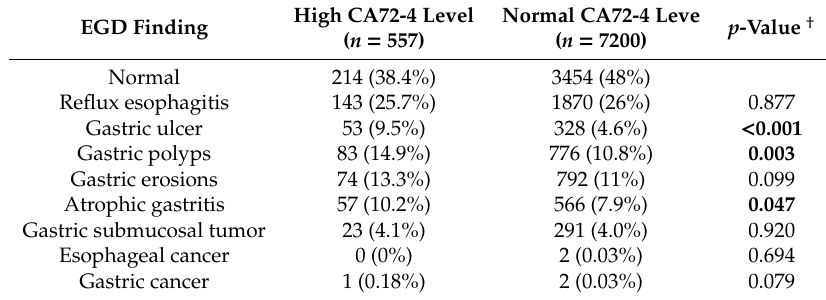
Table 4. Di ff erence in esophagogastroduodenoscopy (EGD) findings between high and normal CA72-4 level groups.